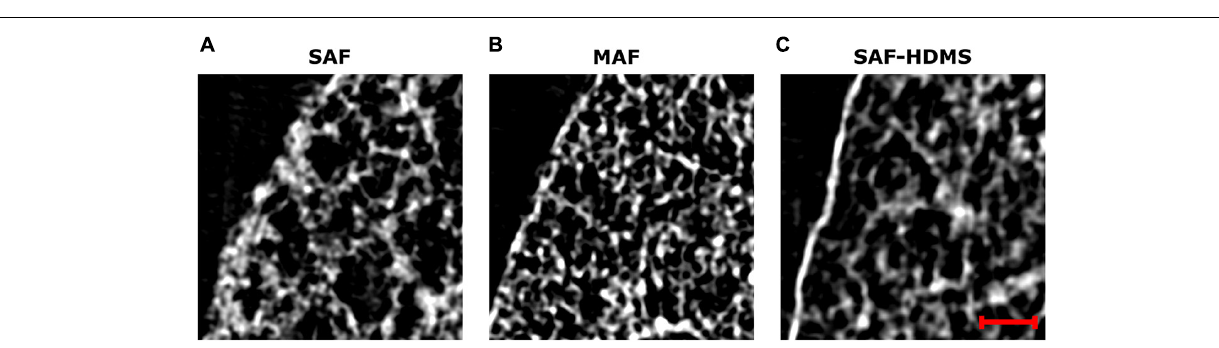
FIGURE 9 | Magnifications of grayscale micro-CT images for subpleural regions of three representative subjects: (A) SAF group, (B) MAF group, and (C) SAF-HMDS group. The red scale bar corresponds to 100 µ